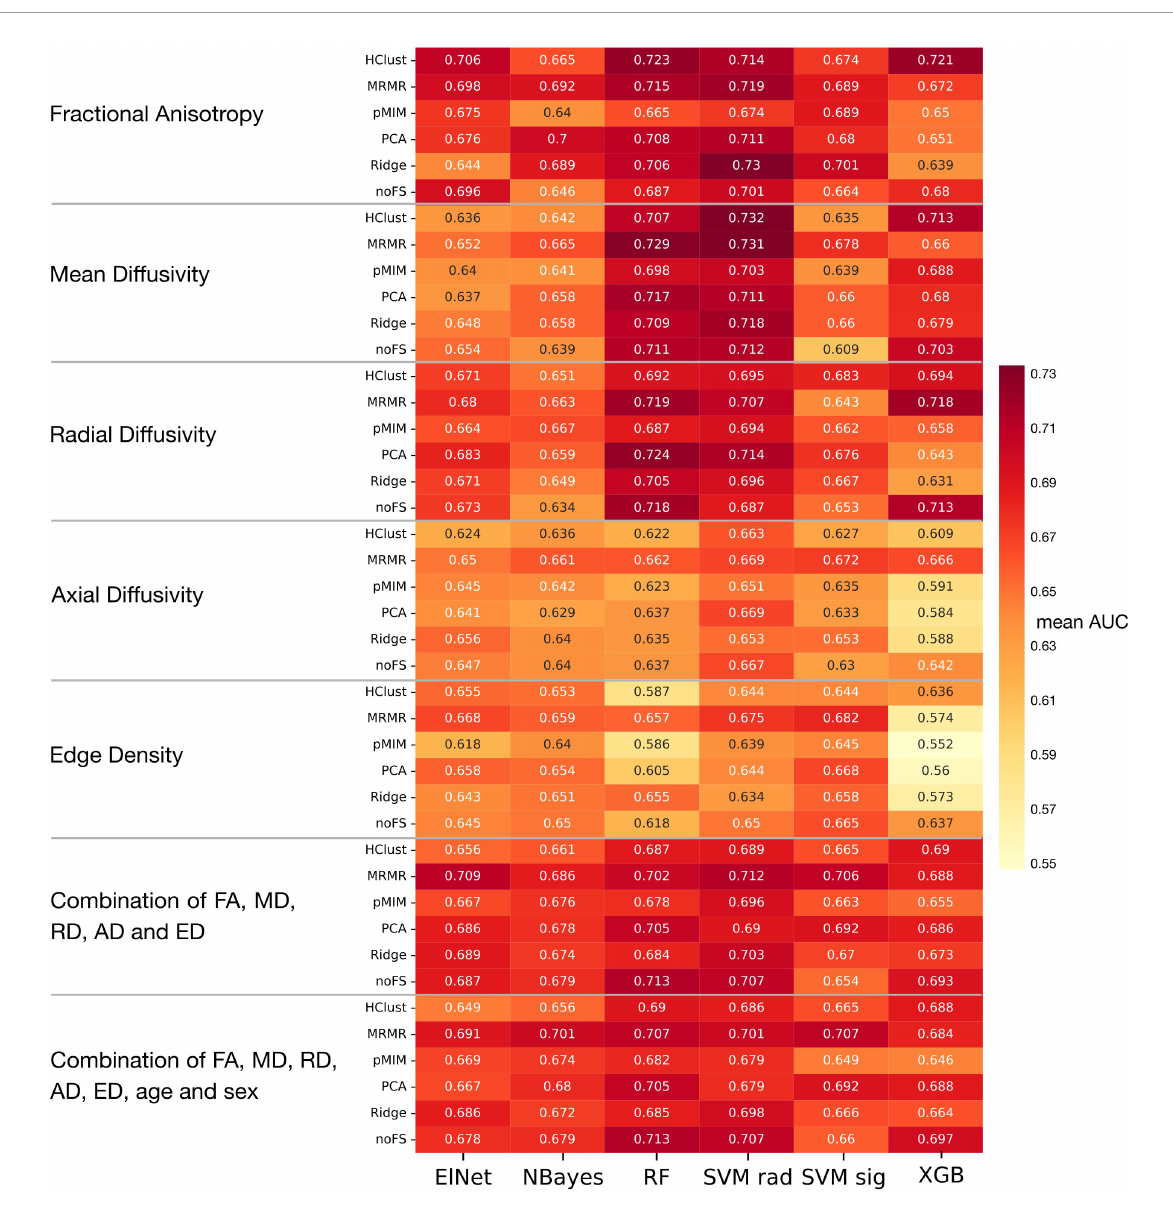
FIGURE5 Heatmap of mean AUC across 100 validation folds in machine learning analysis. Abbreviations see Table 2